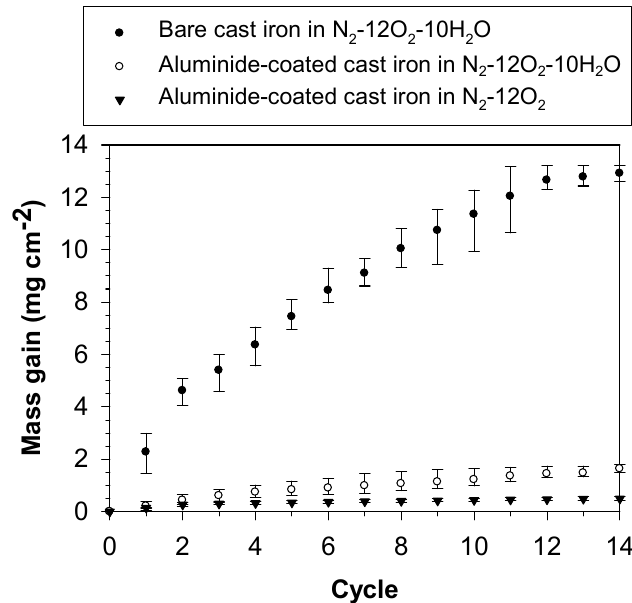
Figure 2. Mass gain of bare and aluminide-coated cast irons during cyclic oxidation at 850 °C.